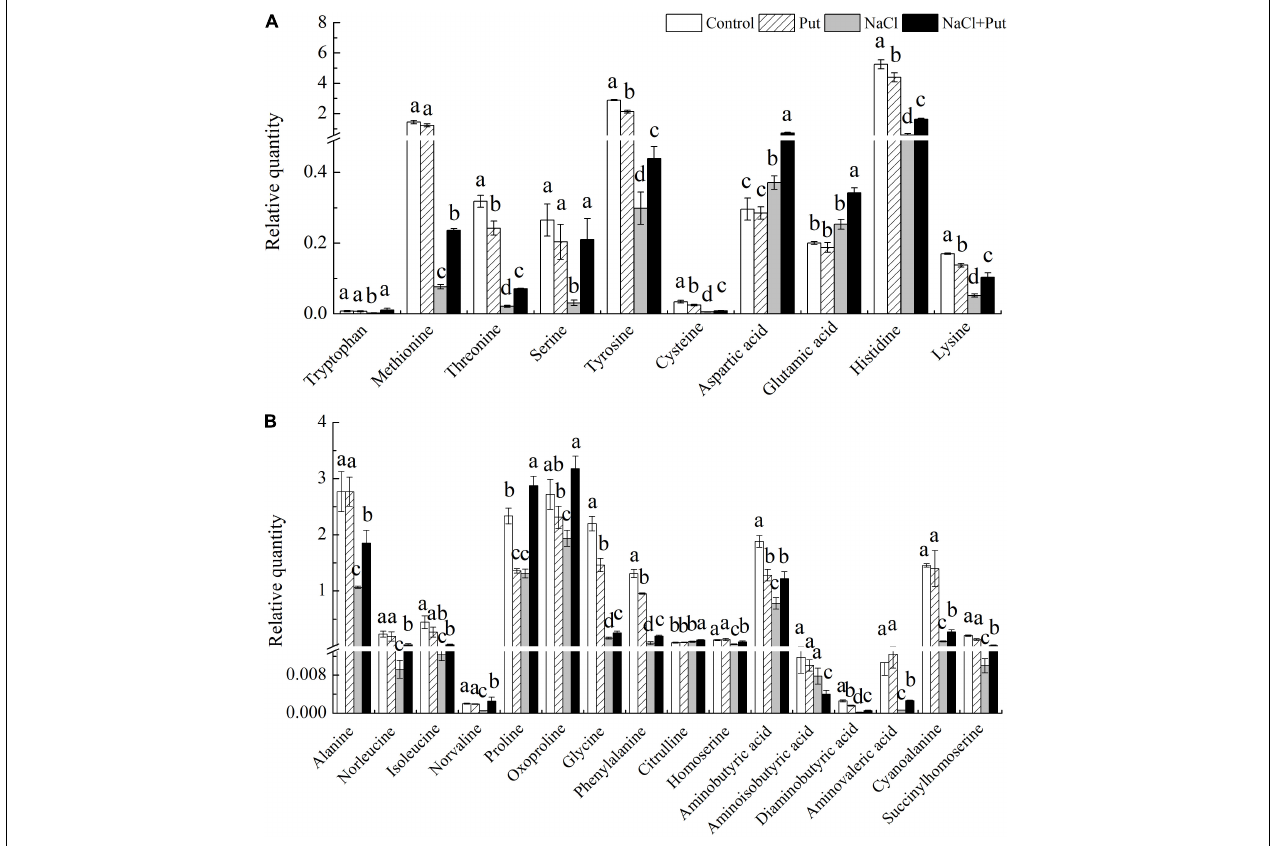
FIGURE 6 | Effects of seed soaking with Put or water on (A) relative polar and (B) non-polar AAs content in white clover seedlings after 7 d of germination under normal condition and salt stress. Vertical bars above columns indicate the standard error of each mean ( n = 4). Different letters indicate a significant difference ( P ≤